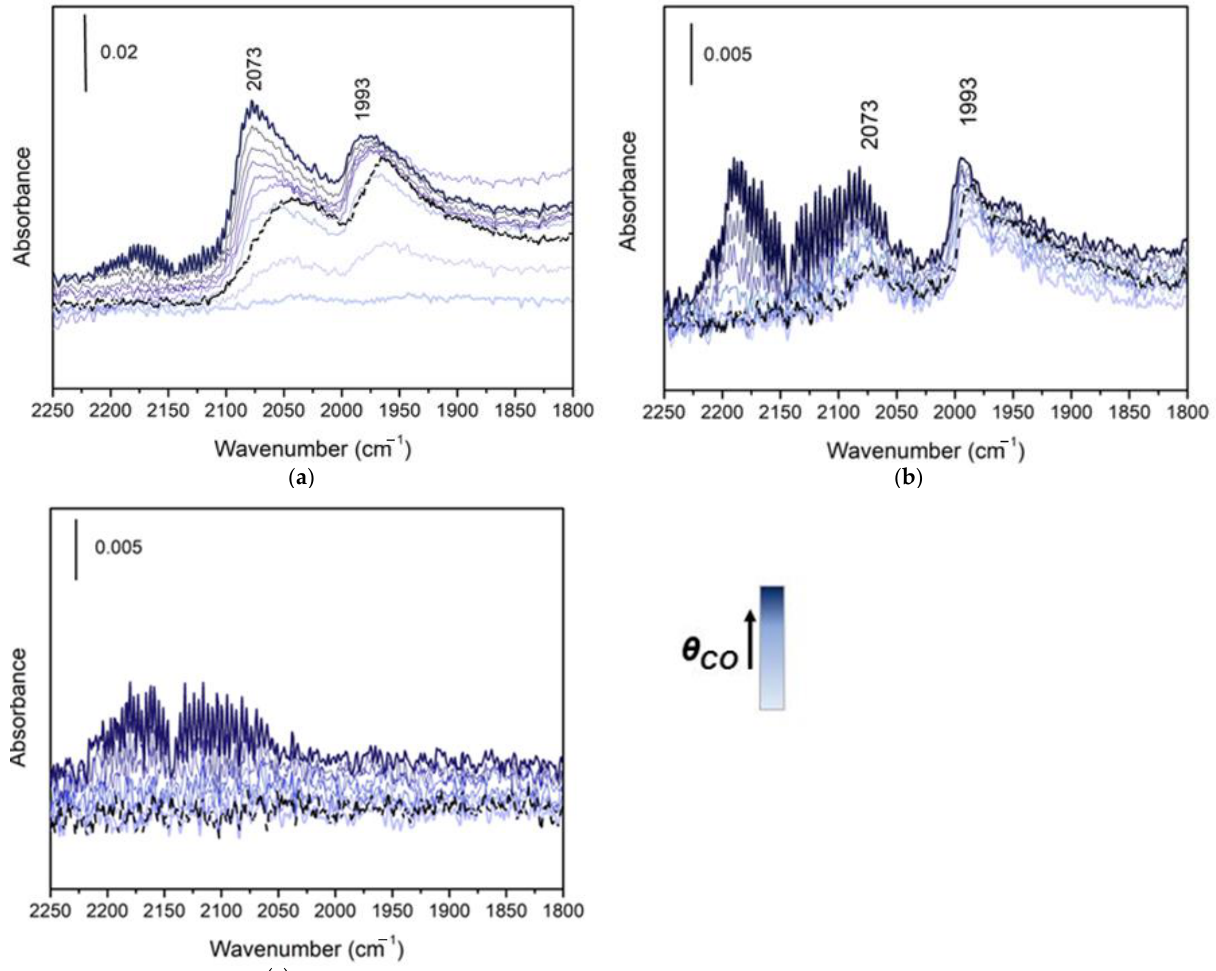
Figure 1. FT-IR spectra of CO adsorption at RT on fresh ( a ), 25,000 km ( b ) and 60,000 km ( c ) sample after 400 °C-0.5 h oxidation-reduction (O 2 -H 2 ) pretreatment at increasing pressure of CO up to 20 mbar and after final outgassing (black dotted line).